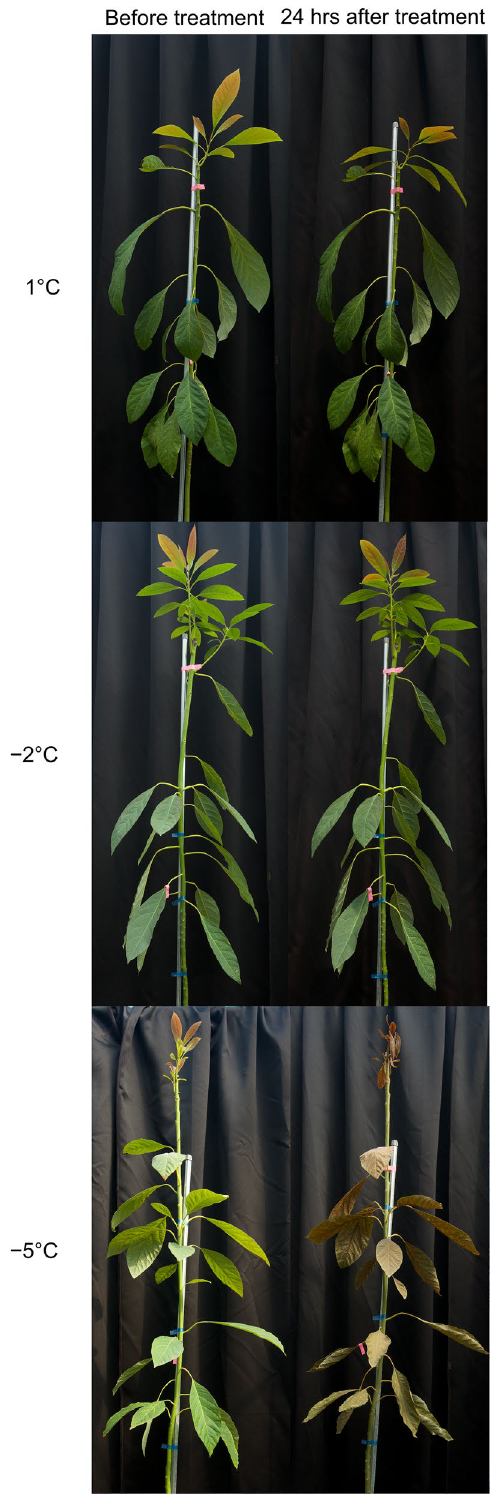
Figure 2. Three-year-old ‘Hass’ avocado seedlings before treatment (left) and 24 h after (right) treated with 1 (top), − 2 (middle), and − 5 °C (bottom) for 1